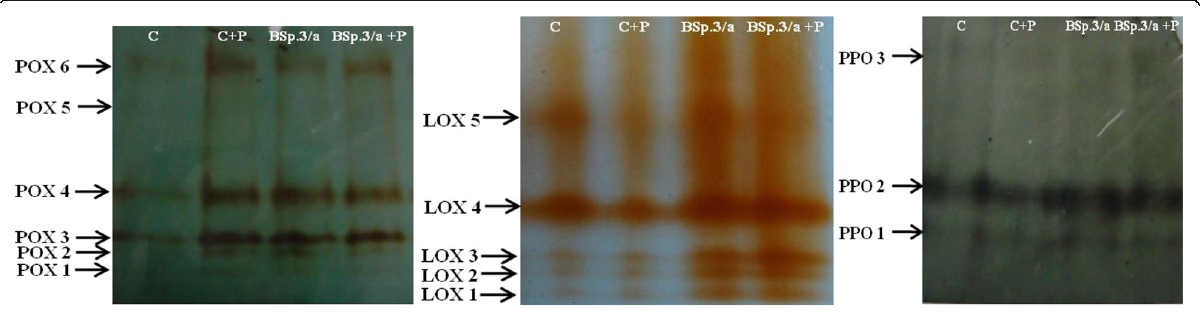
Fig. 4 Isoform profiles of PAL, POX, PPO, and LOX